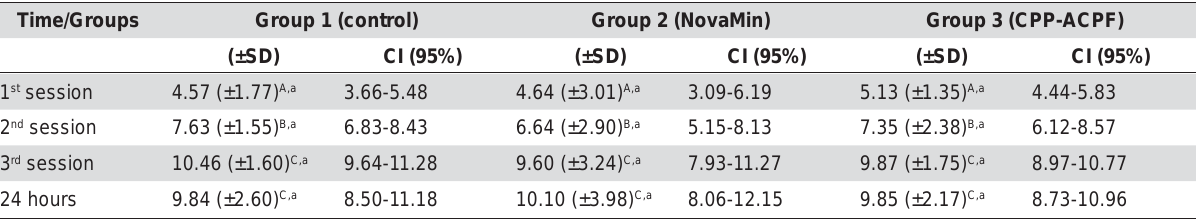
Table 2- (cid:3)(cid:48)(cid:72)(cid:68)(cid:81)(cid:86)(cid:15)(cid:3)(cid:86)(cid:87)(cid:68)(cid:81)(cid:71)(cid:68)(cid:85)(cid:71)(cid:3)(cid:71)(cid:72)(cid:89)(cid:76)(cid:68)(cid:87)(cid:76)(cid:82)(cid:81)(cid:86)(cid:15)(cid:3)(cid:68)(cid:81)(cid:71)(cid:3)(cid:28)(cid:24)(cid:8)(cid:3)(cid:70)(cid:82)(cid:81)(cid:191)(cid:71)(cid:72)(cid:81)(cid:70)(cid:72)(cid:3)(cid:76)(cid:81)(cid:87)(cid:72)(cid:85)(cid:89)(cid:68)(cid:79)(cid:86)(cid:3)(cid:82)(cid:73)(cid:3)(cid:507)(cid:40)(cid:3)(cid:89)(cid:68)(cid:79)(cid:88)(cid:72)(cid:86)(cid:3)(cid:82)(cid:73)(cid:3)(cid:87)(cid:75)(cid:72)(cid:3)(cid:88)(cid:83)(cid:83)(cid:72)(cid:85)(cid:3)(cid:76)(cid:81)(cid:70)(cid:76)(cid:86)(cid:82)(cid:85)(cid:86)(cid:15)(cid:3)(cid:68)(cid:70)(cid:70)(cid:82)(cid:85)(cid:71)(cid:76)(cid:81)(cid:74)(cid:3)(cid:87)(cid:82)(cid:3)(cid:72)(cid:91)(cid:83)(cid:72)(cid:85)(cid:76)(cid:80)(cid:72)(cid:81)(cid:87)(cid:68)(cid:79)(cid:3)(cid:74)(cid:85)(cid:82)(cid:88)(cid:83)(cid:3) and session